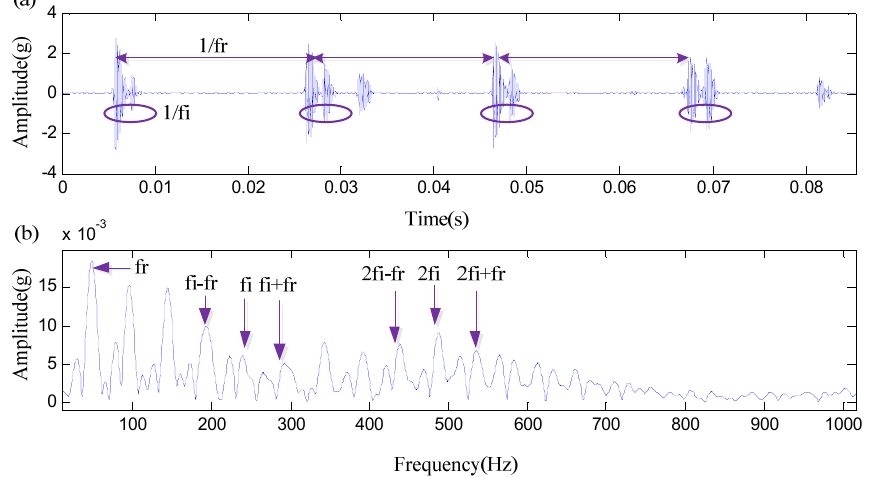
Figure 12. ( a ) De-noising signal by NSD. ( b ) Local envelope spectrum.